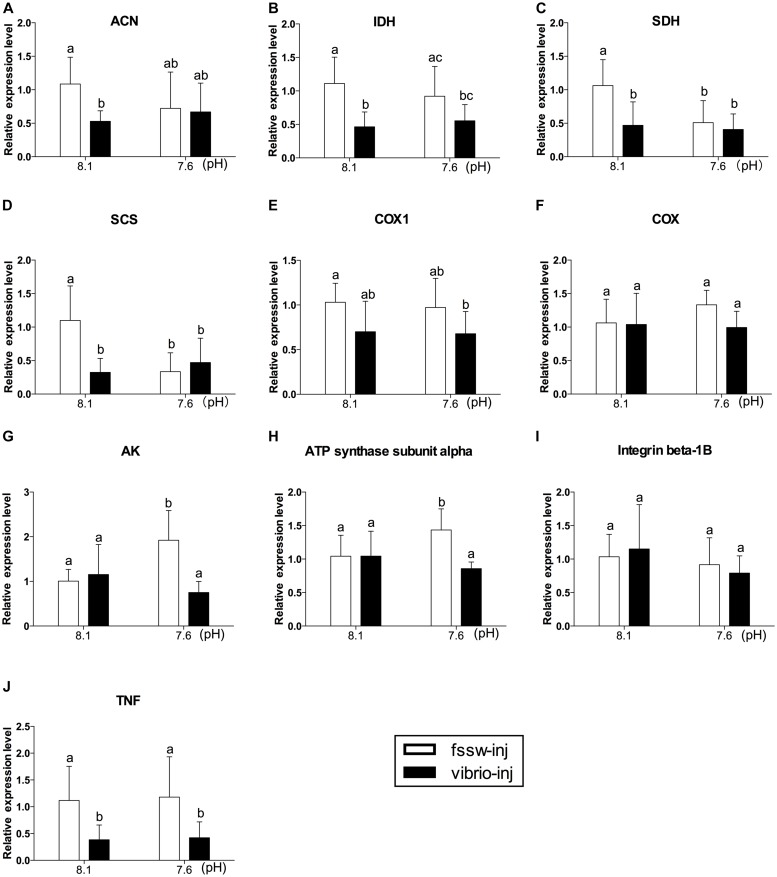
The mRNA expression profiles of aerobic energy metabolism- and immune-related genes in the digestive glands of oysters post elevated pCO2 and V. splendidus exposure. (A) ACN. (B) IDH. (C) SDH. (D) SCS. (E) COX 1. (F) COX. (G) AK. (H) ATP synthase subunit alpha. (I) Integrin beta-1B. (J) TNF. Each bar represents mean ± SD (n = 6). Different letters indicate significant differences among treatments (p < 0.05), and identical letters indicate no significant difference.